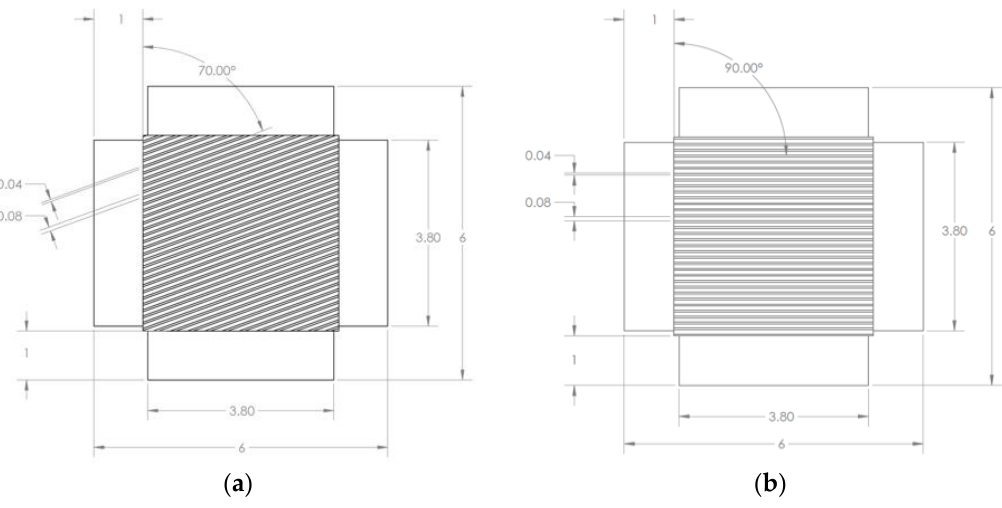
Figure 4. Schematics of the foil strain gauge substrates showing the grooves. ( a ) Grooves oriented at 70°; ( b ) Grooves oriented at 0° or 90°. Dimensions are in mm.